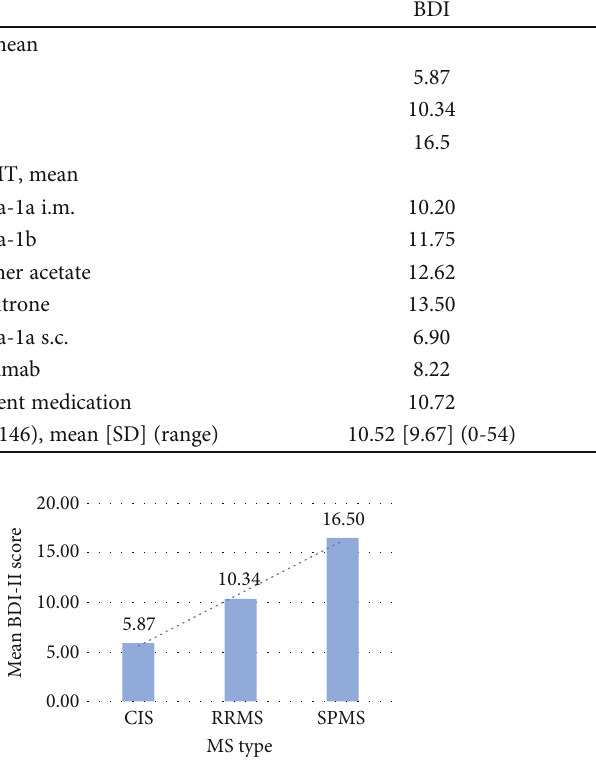
Table 3: Psychological test score details according to MS type and treatment.